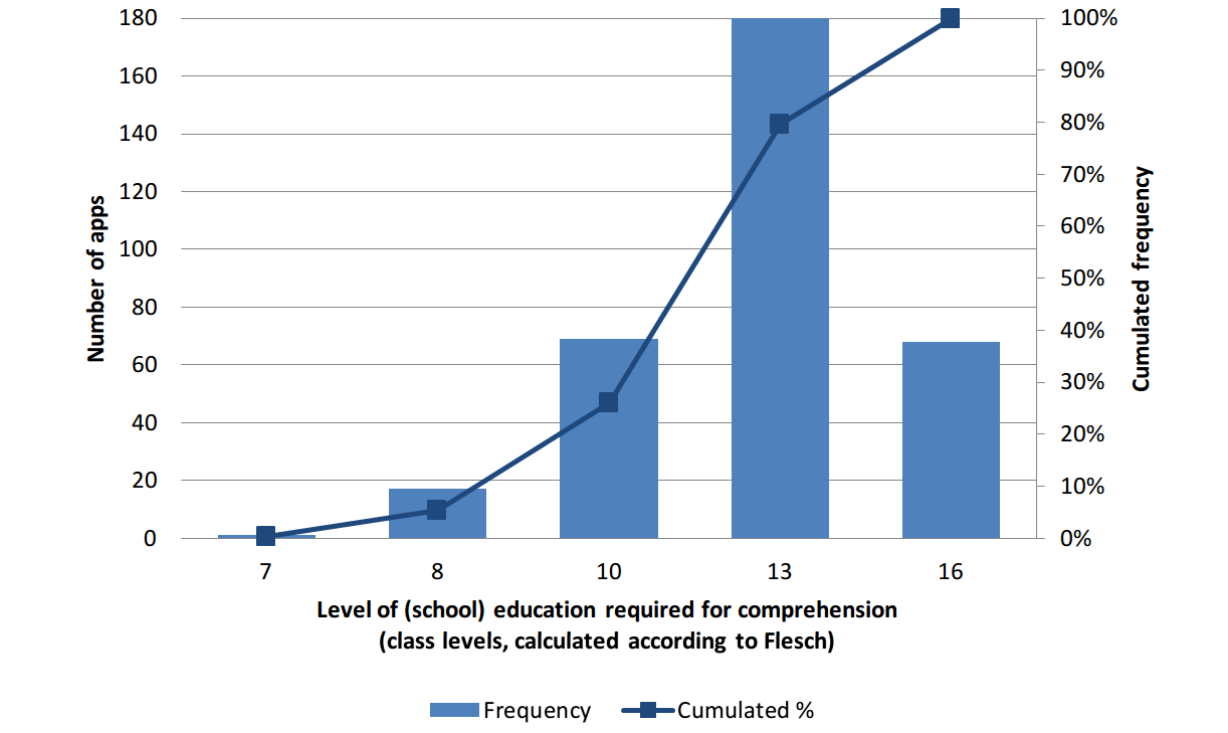
Figure 4. Distribution of the educational levels required for comprehending the description texts of apps related to